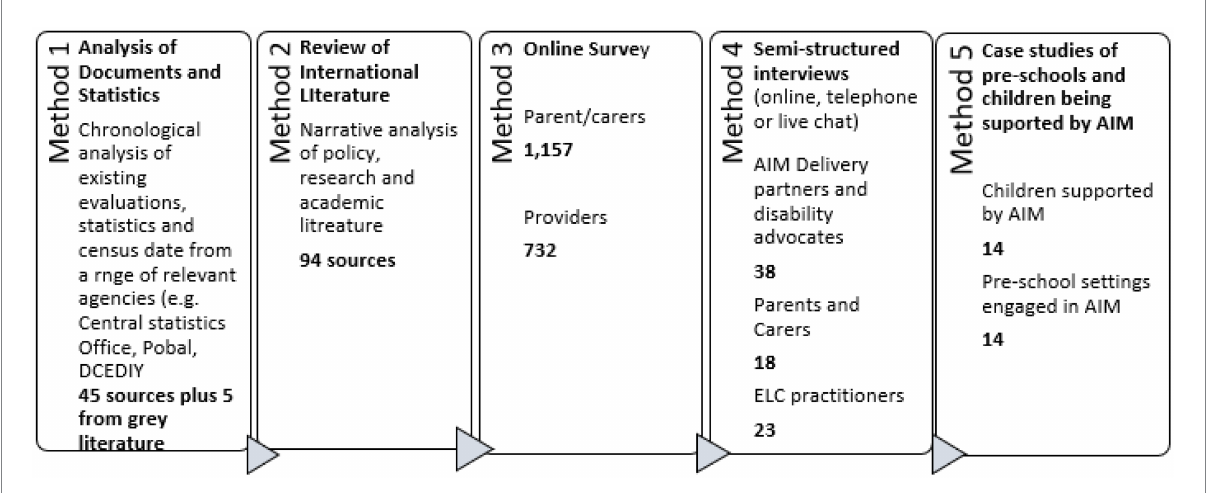
FIGURE 1 Summary of methods applied to the evaluation of the Access and Inclusion